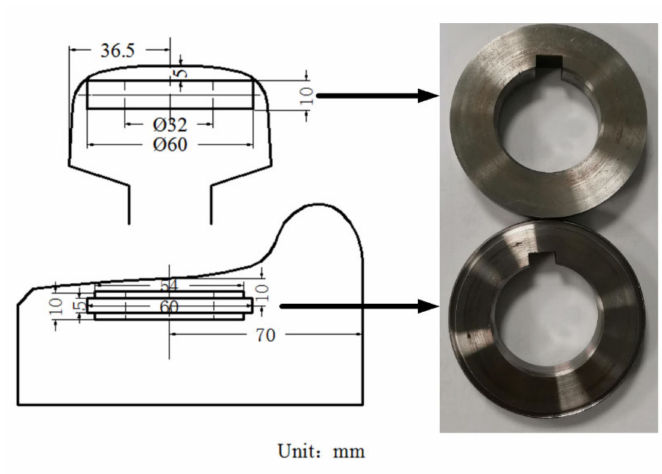
Figure 1. The left picture shows the sampling position and size on the real engineering components, the right picture shows the actual test rollers.